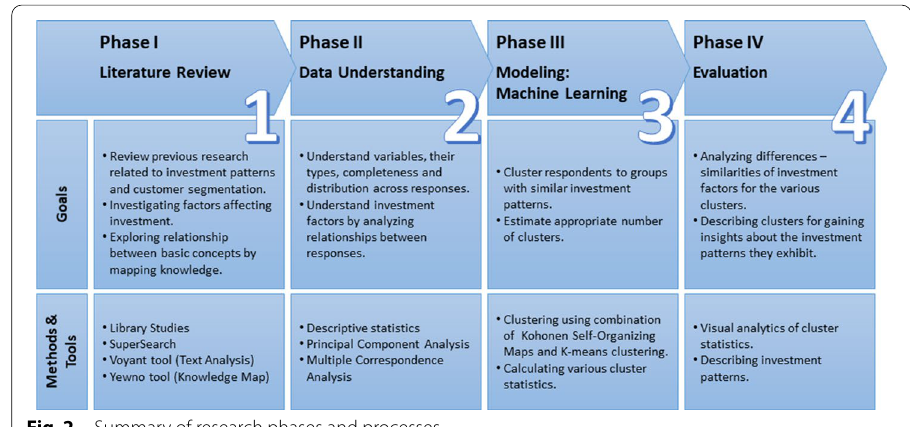
Fig. 2 - Summary of research phases and